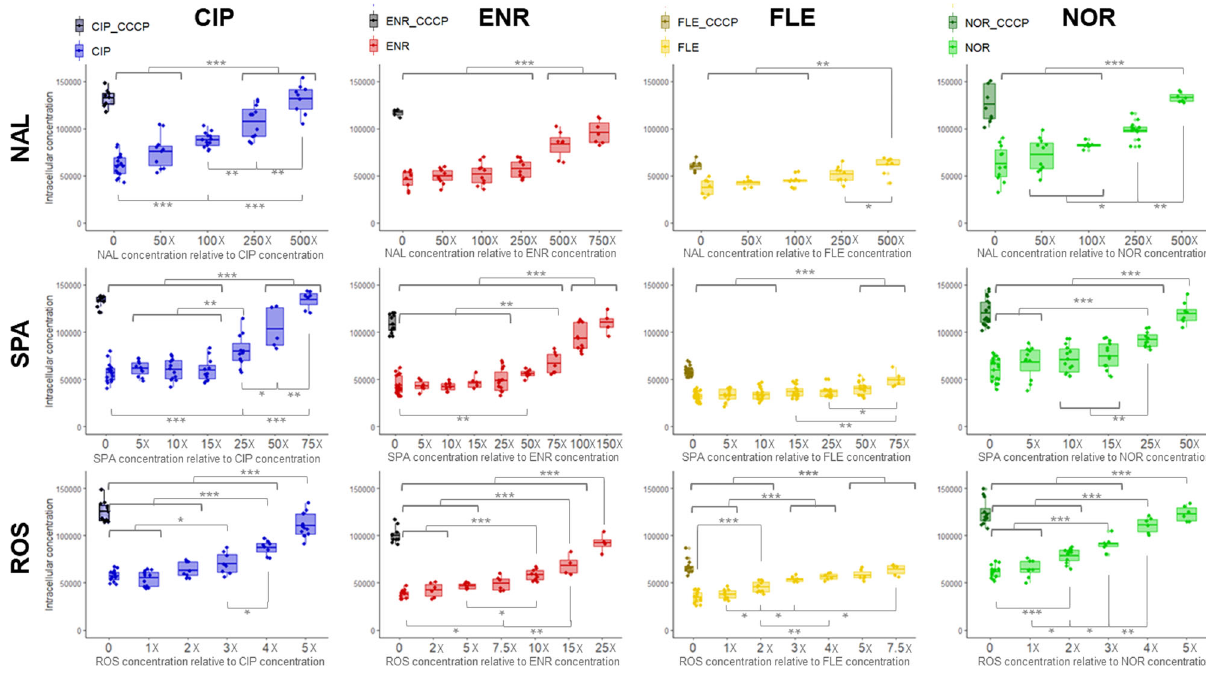
Fig. 1 CPTs dose effect on FQs intracellular accumulation in bacterial population. Boxplot of intracellular concentrations of FQs (CIP, ENR, FLE, NOR, in molecules.cell − 1 ) accumulated in EA27 incubated without or with CCCP, or with increasing concentrations of CPTs (NAL SPA, ROS). The concentrations used during incubations were 8 µ g.ml − 1 FQ, 20 µ M CCCP, X molar equivalent of CPTs relative to the co-incubated FQ concentration. Bacterial suspensions were sampled at 20 min and intracellular concentrations of FQ were determined using spectro fl uorimetry (see ‘ Methods ’ ). Results were obtained from n = 4, 4, 4, 4, 4, 4, 6, 4, 3, 3, 3, 3 independent experiments performed in triplicate. ANOVAs with Tukey ’ s posthoc tests (F(4,53) = 59.4, P < 2 10 − 16 ; F(6,49) = 30.5, P = 5.9 10 − 15 ; F(4,31) = 25.7, P = 1.84 10 − 9 ; F(4,42) = 48.4, P = 3.4 10 − 15 ; F(6,69) = 53.3, P < 2 10 − 16 ; F(8,76) = 60.7, P < 2 10 − 16 ; F(6,93) = 9.7, P = 2.8 10 − 8 ; F(5,70) = 38, P < 2 10 − 16 ; F(5,57) = 72.4, P < 2 10 − 16 ; F(6,41) = 45, P < 2 10 − 16 ; F(6,54) = 45.3, P < 2 10 − 16 . F(5,45) = 91.9,